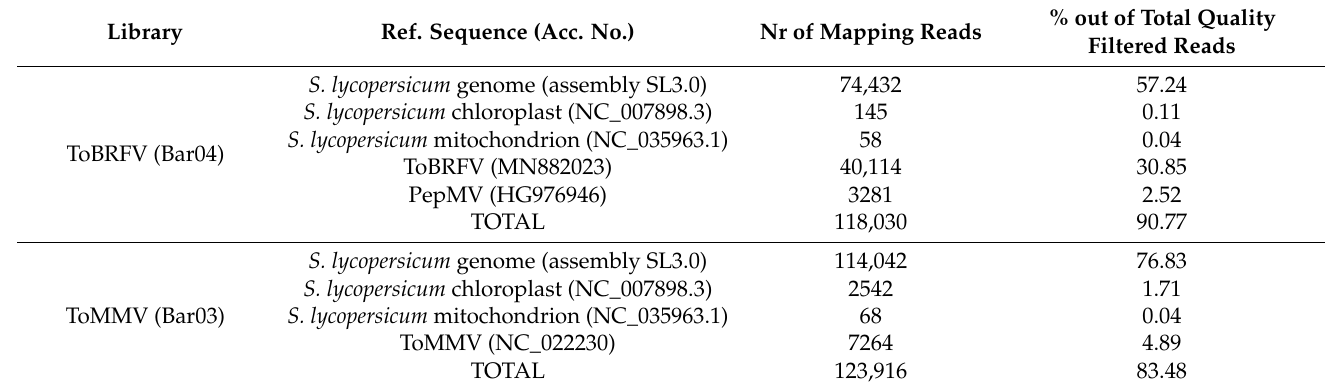
Table 2. Summary table of reads aligned to reference